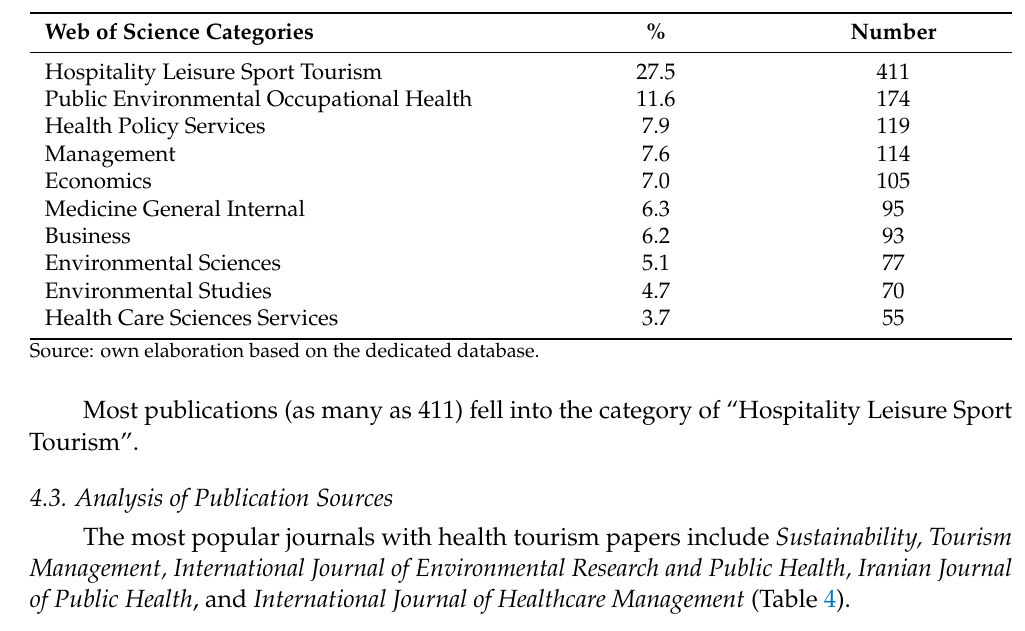
Table 3. Web of Science